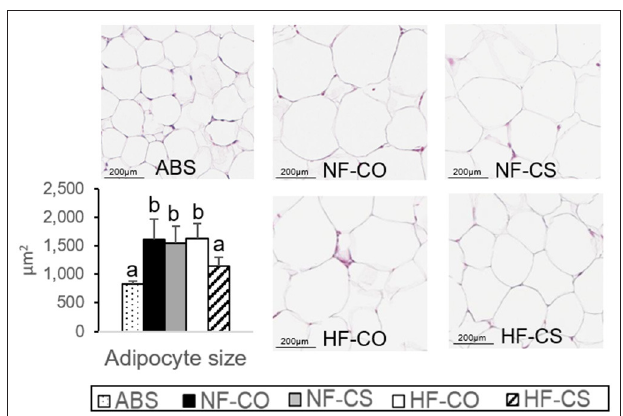
FIGURE 1 | Normalization of adipocyte size by choline supplementation. H&E staining of offspring visceral adipose tissue after 6-week post-weaning high-fat feeding. Adipocyte size was assessed by the Adiposoft plugin in ImageJ. Different letters (e.g., a, b) represent statistically significant difference, p < 0.05. n = 6–8 per sex per group. ABS, absolute control; CO, control without choline supplement; CS, choline supplemented; HF, high-fat; NF,